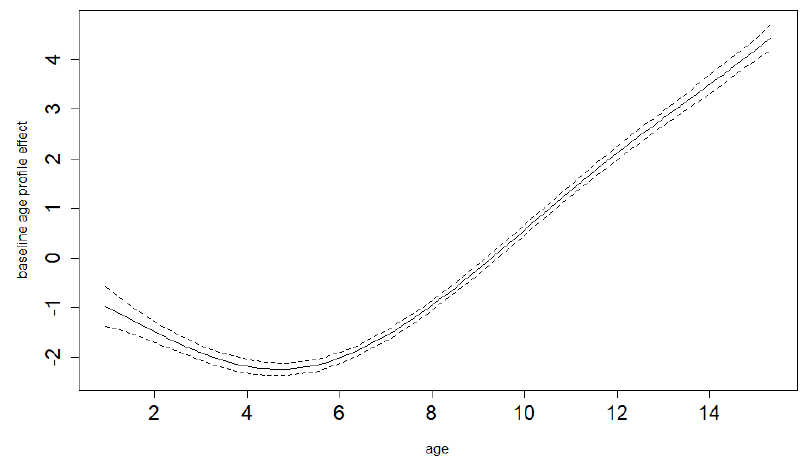
Figure 3. Baseline BMI age profile for boys, estimated smooth trend (solid line) and pointwise 95% confidence interval limits (dotted lines). Age in years.